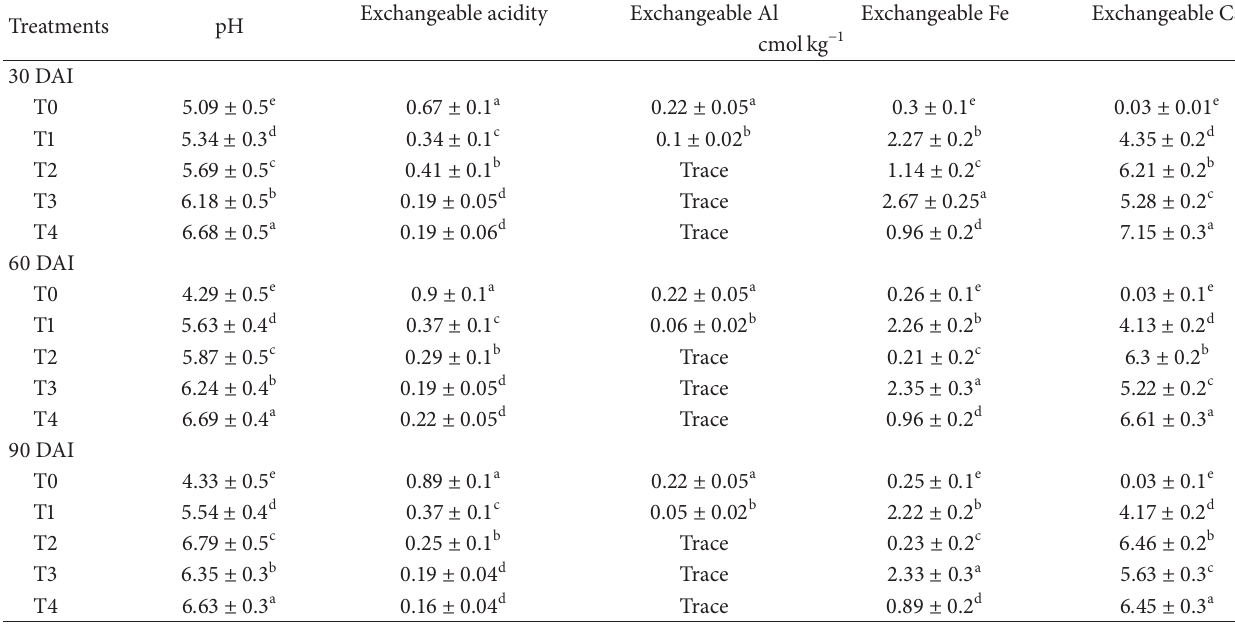
Table 4: Effects of organic amendments and incubation time on the soil pH, exchangeable acidity, exchangeable Al, exchangeable Fe, and exchangeable Ca.